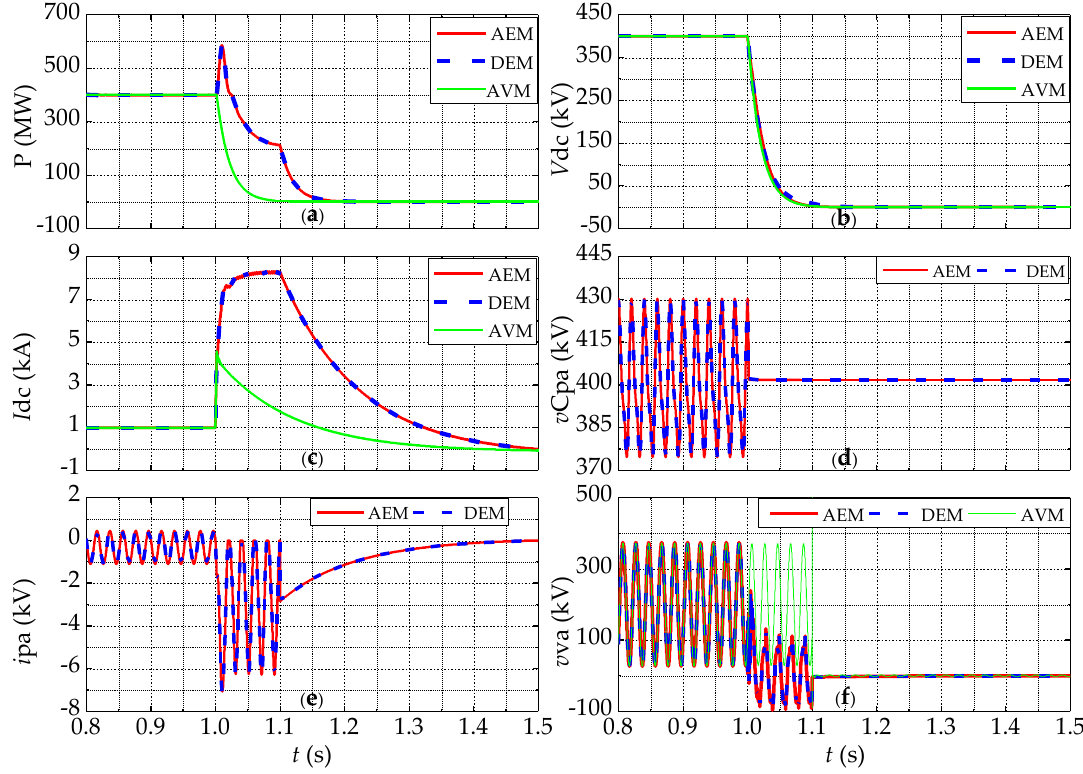
Figure 12. DC fault. ( a ) MMC1 active power; ( b ) DC voltage; ( c ) DC current; ( d ) SMs capacitor voltage; ( e ) Current on the upper arm in phase a ; ( f ) AC voltage in phase a at valve-side.